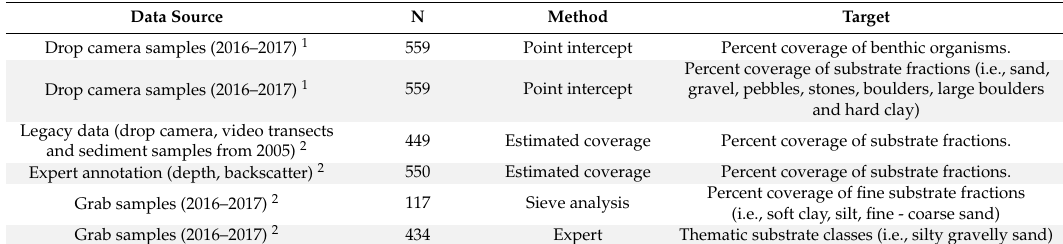
Table 3. List of sources of training and testing data according to purpose of application. Tables A4 and A5 in Appendix A show the distribution of HUB classes within the data. N Percent coverage of benthic organisms. Percent coverage of substrate fractions (i.e., sand, gravel, pebbles, stones, boulders, large boulders and hard clay) Legacy data (drop camera, video transects 449 Percent coverage of substrate and sediment samples from 2005) 2